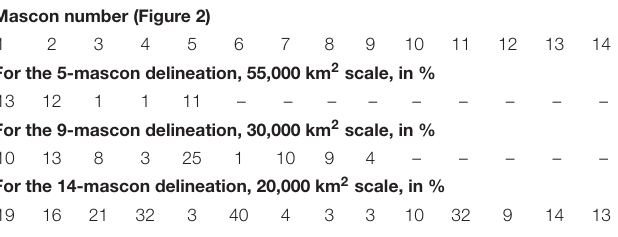
Frontiers in Earth Science |